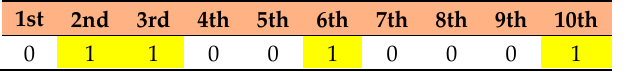
Table 1. The ten utilized benchmark datasets.